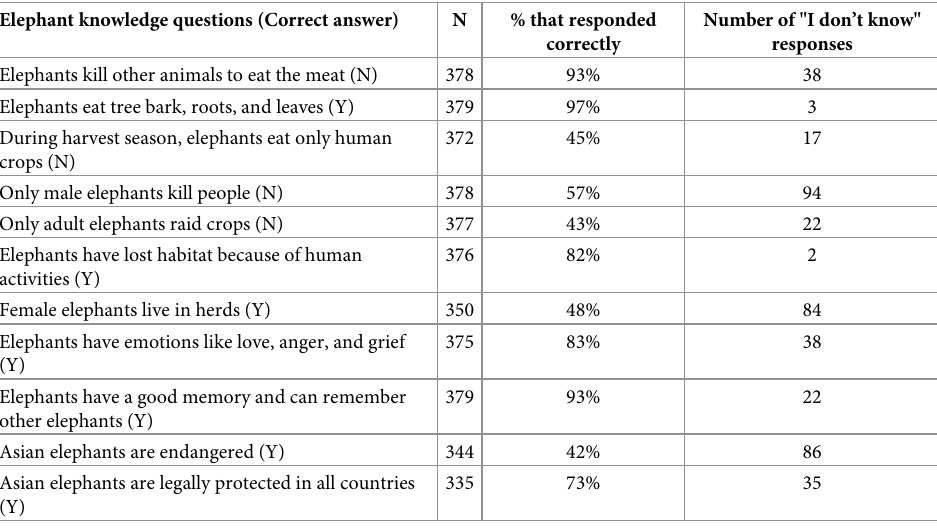
Table 1. Local people’s knowledge about Asian elephant natural history, behavior, and conservation in the Bago- Yangon and Ayeyarwady regions of Myanmar from May 2017 to December 2018. Elephant knowledge questions (Correct answer) N % that responded Number of "I don’t know" correctly responses Elephants kill other animals to eat the meat (N) 378 93% 38 Elephants eat tree bark, roots, and leaves (Y) 379 97% 3 During harvest season, elephants eat only human 372 45% 17 crops (N) Only male elephants kill people (N) 378 57% 94